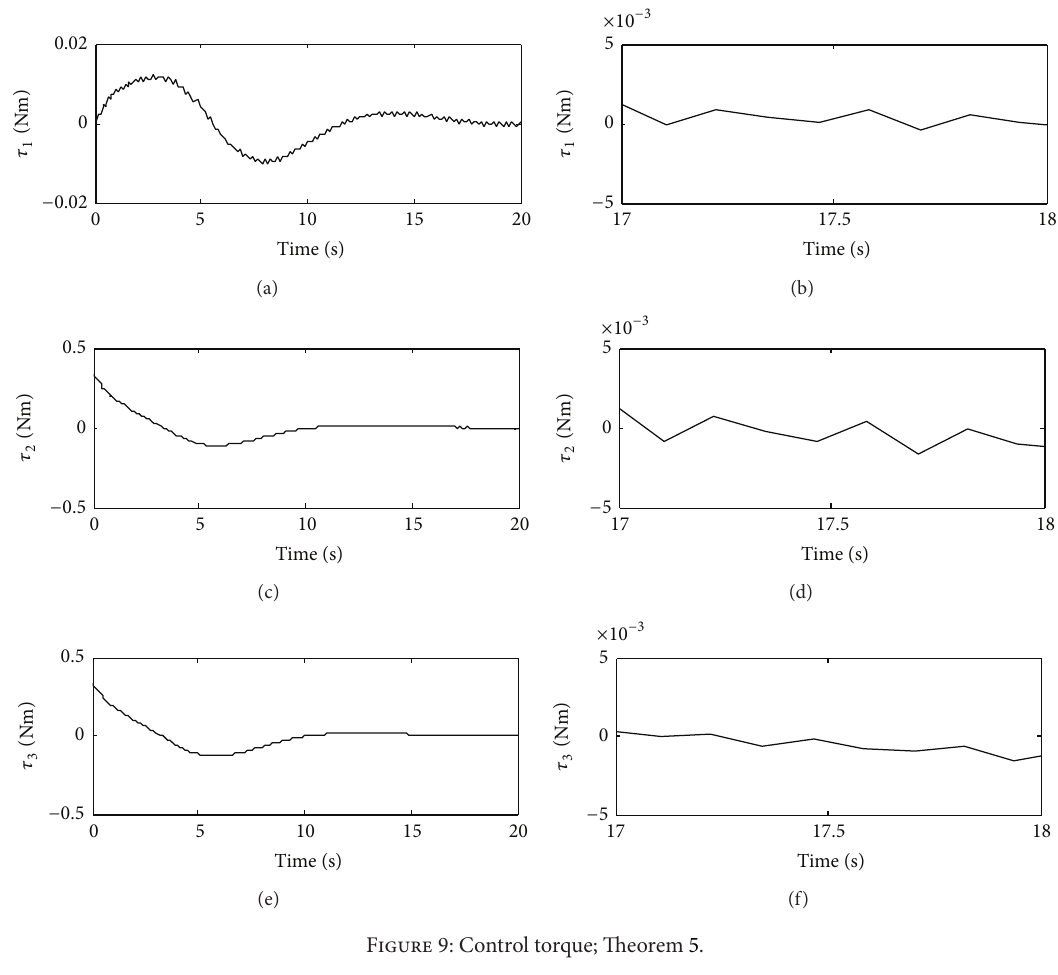
Figure 9: Control torque; Theorem